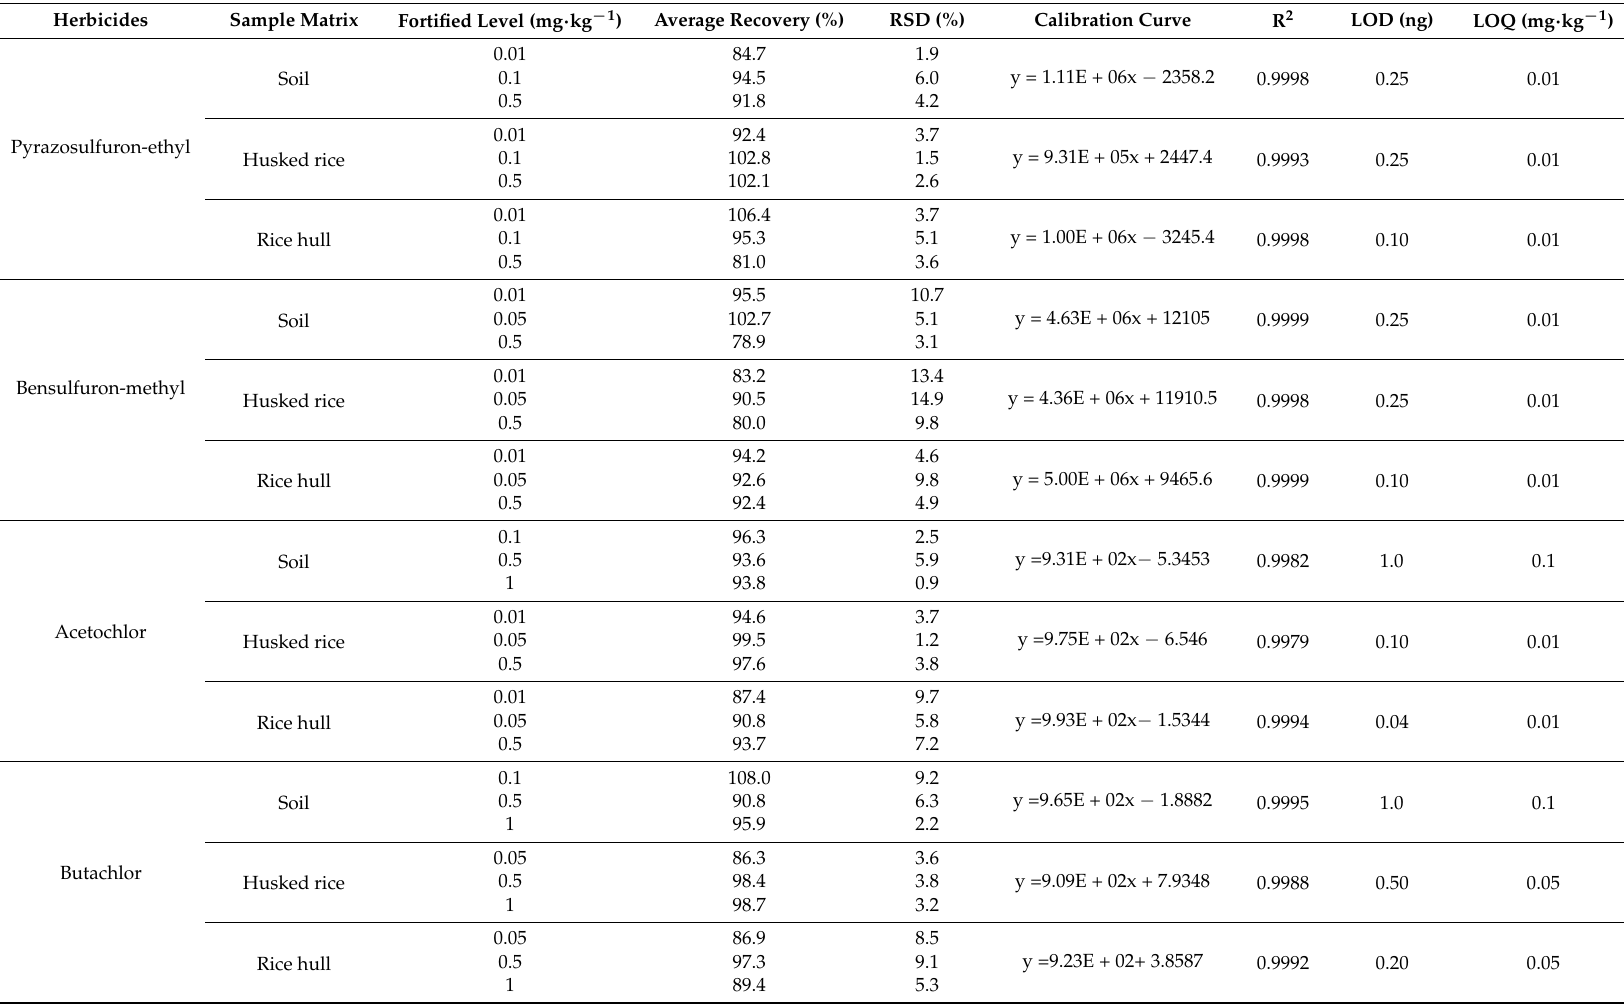
Table 4. The average recovery, calibration curve, the limits of detection (LODs), and limits of quantification (LOQs) of the four herbicides in soil, husked rice, and rice hull (n =